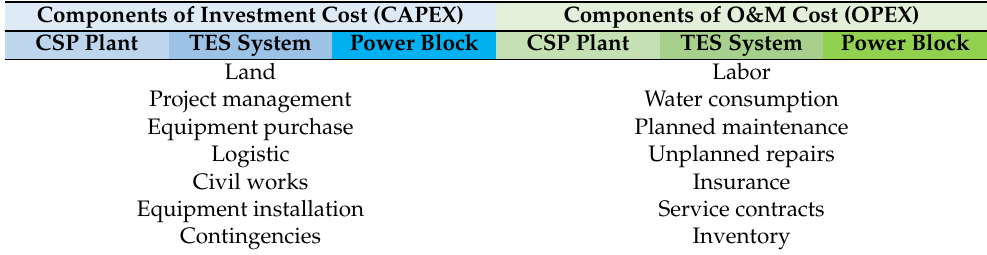
Table 1. LCOE components